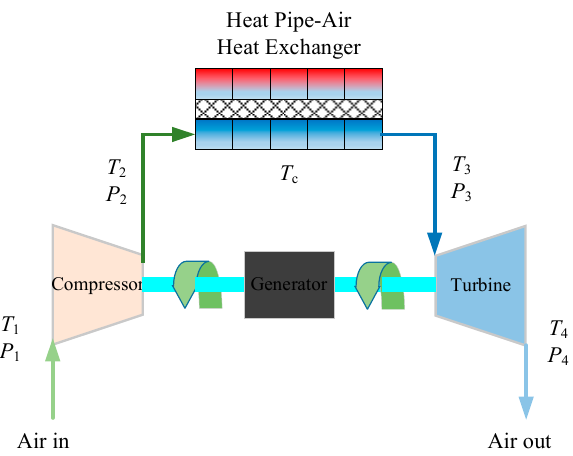
Figure 8. Schematic of simple air Brayton power cycle.